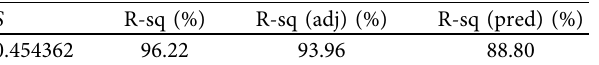
Table 5: Model summary (HV).